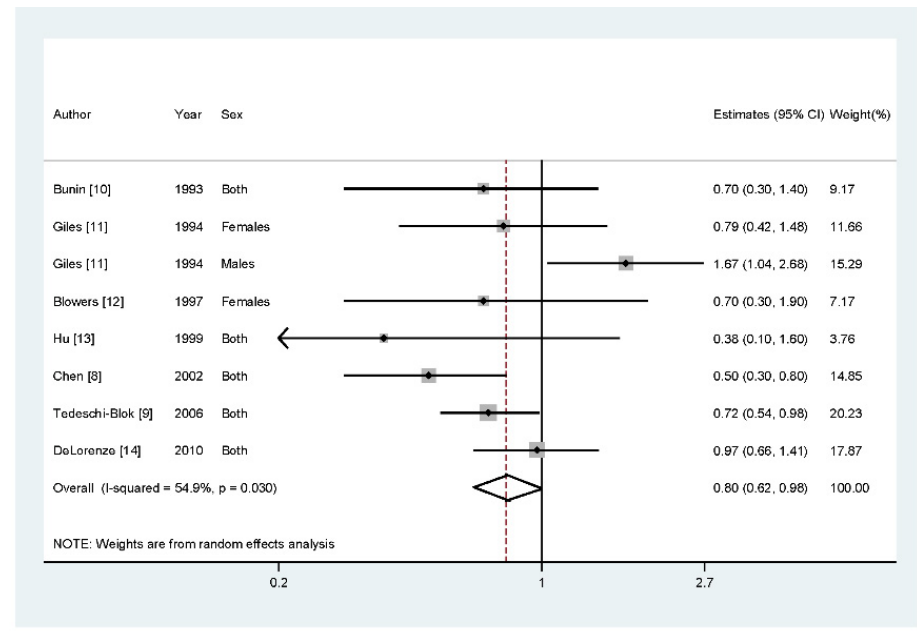
Figure 2. The forest plot between highest versus lowest categories of vitamin A intake and glioma risk.